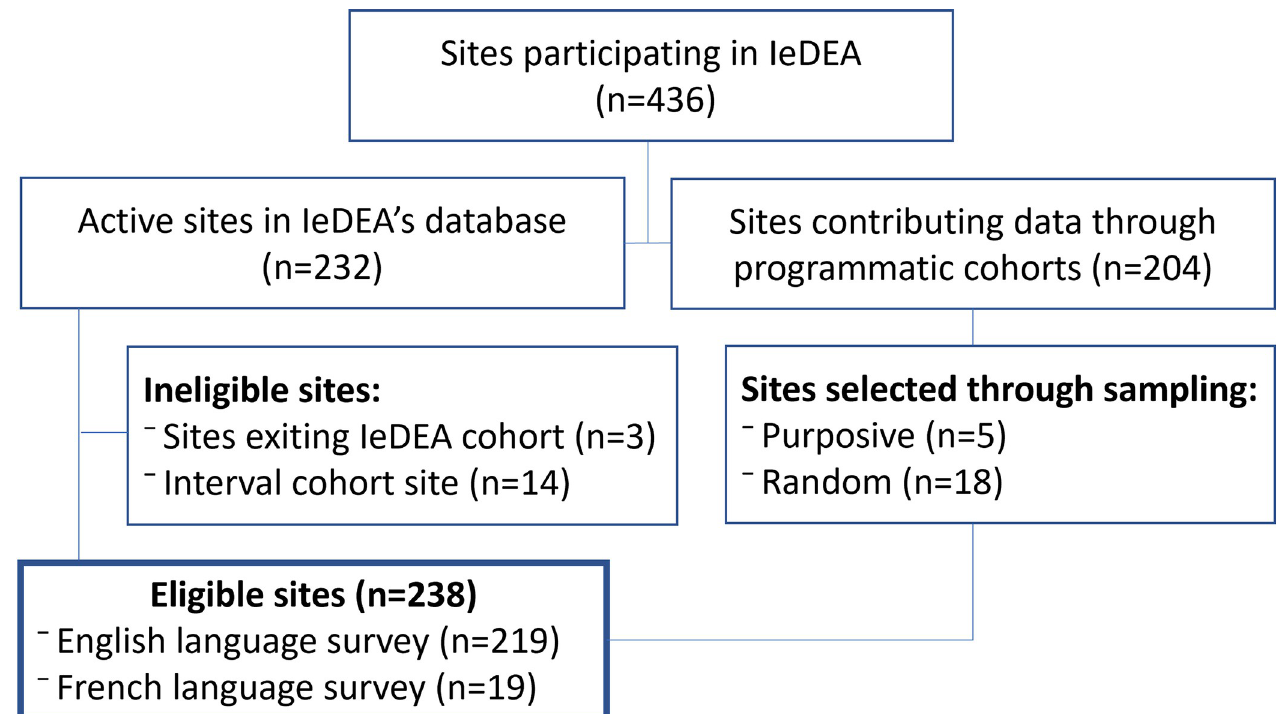
Fig 2. Site inclusion